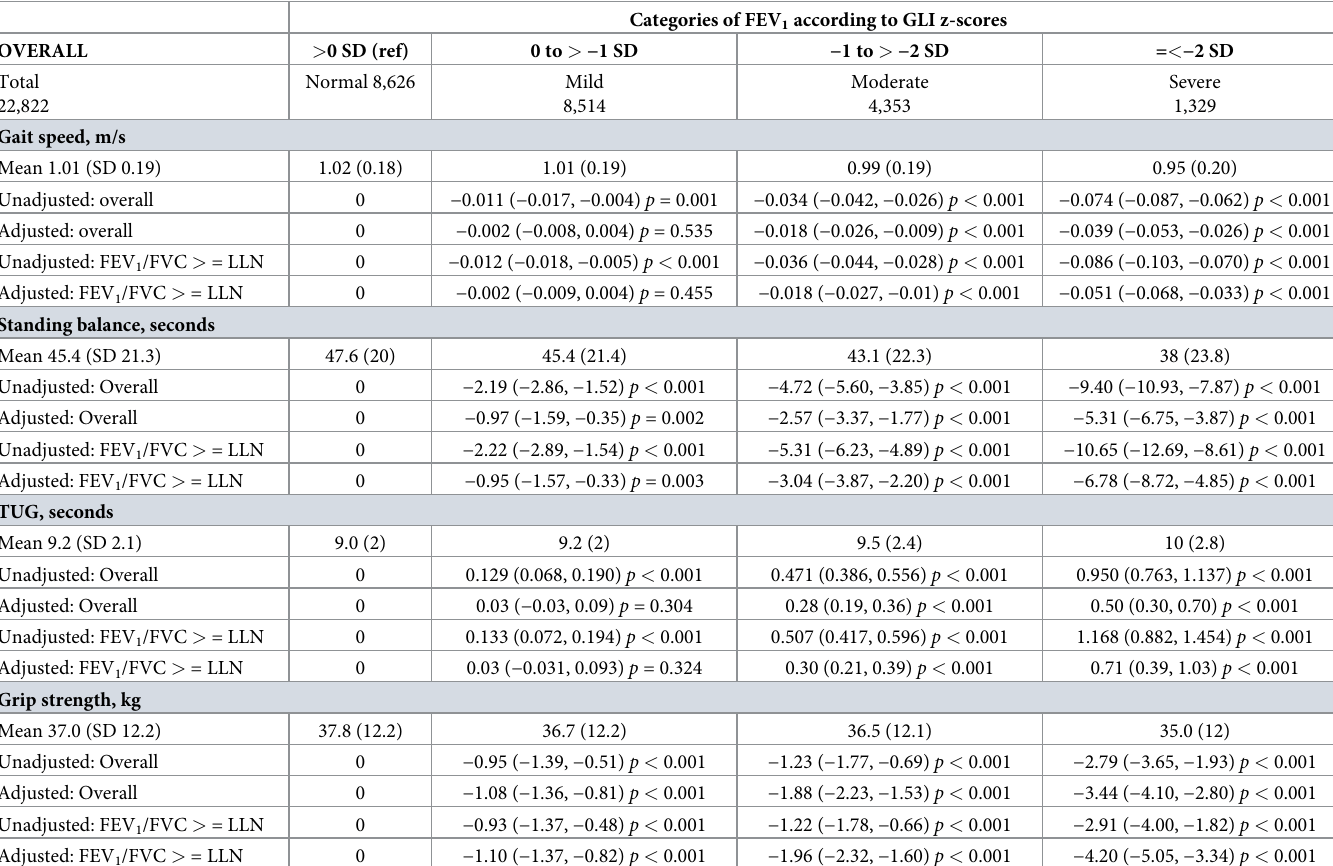
Table 3. Mean differences (unadjusted and adjusted) in physical performance by different grades of low FEV 1 compared to reference group (FEV 1 > 0 SD) for the overall cohort and subgroup without AO on spirometry (shown here as FEV 1 /FVC > = LLN). Categories of FEV 1 according to GLI